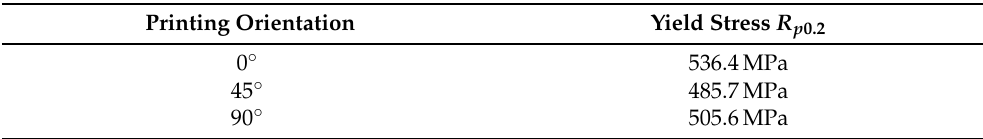
Table 1. Evaluated values of the yield stress for each printing